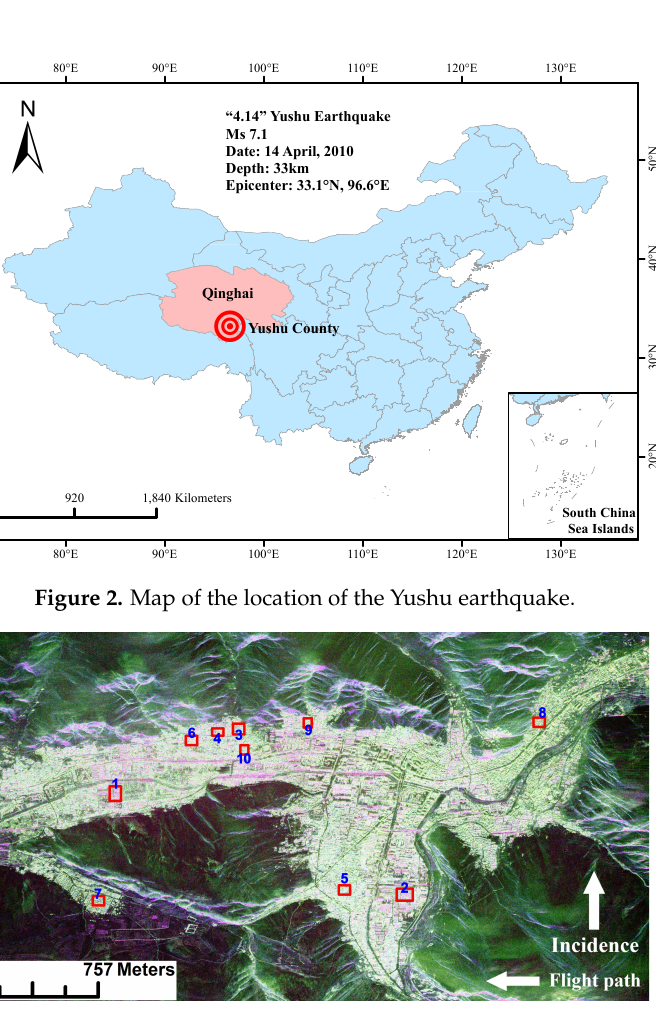
Figure 3. Pauli RGB color composite image for the PolSAR data of Yushu County, with red (|HH − VV|), green (|HV|), and blue (|HH + VV|). The ten areas marked by red rectangle boxes are the samples of five kinds of buildings. No. 1–No. 10 areas are No. 1 sample of intact parallel buildings, No. 2 sample of intact parallel buildings, No. 1 sample of damaged parallel walls, No. 2 sample of damaged parallel walls, No. 1 sample of collapsed buildings, No. 2 sample of collapsed buildings, No. 1 sample of intact oriented buildings, No. 2 sample of intact oriented buildings, No. 1 sample of damaged oriented walls and No. 2 sample of damaged oriented walls, respectively.